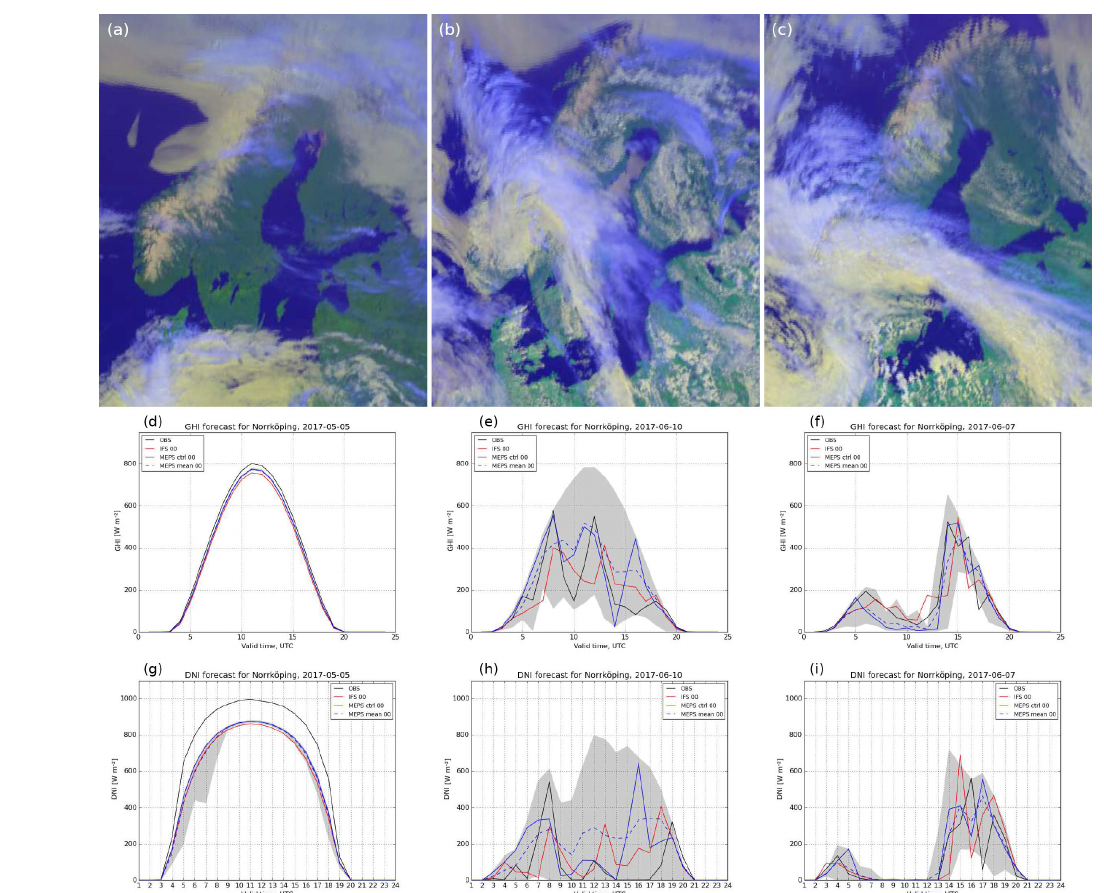
Figure 4. Three cases illustrating forecasts for different cloud conditions: clear (a) , mixed (b) and overcast (c) . Top row: cloud images from Meteosat. Middle row: GHI forecasts. Bottom row: DNI